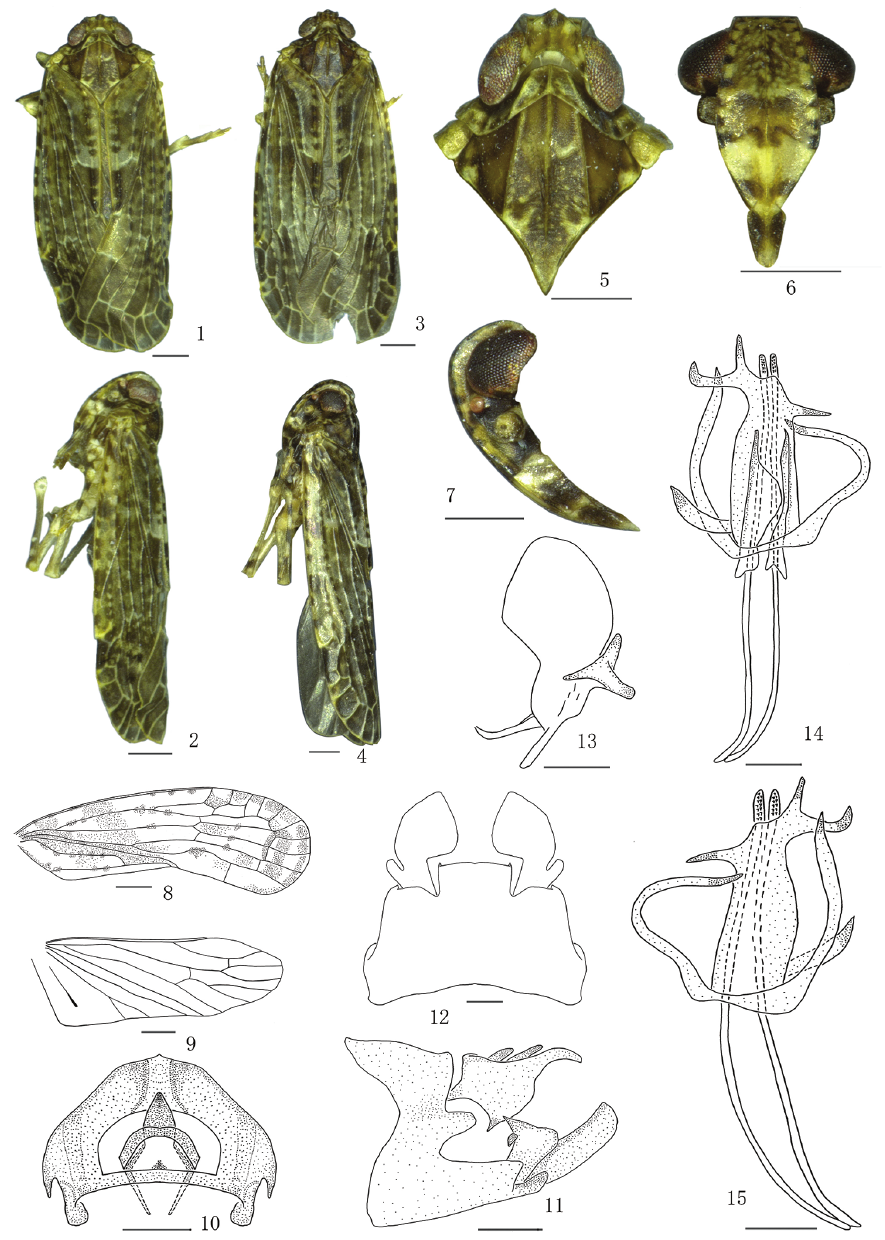
Figures 1–15. Magadhaideus luchunensis sp. n. 1–2 Male habitus (dorsal and lateral views) 3–4 Female habitus (dorsal and lateral views) 5 Head and thorax, dorsal view 6 Face 7 Head, lateral view 8 Forewing 9 Hindwing 10 Anal segment of male, dorsal view 11 Male genitalia, lateral view 12 Male genitalia, ventral view 13 Left genital style, dorsal view 14 Aedeagus, dorsal view 15 Aedeagus, ventral view. Scale bars: 0.2 mm ( 8–13 ); 0.5 mm ( 5–7, 14–15